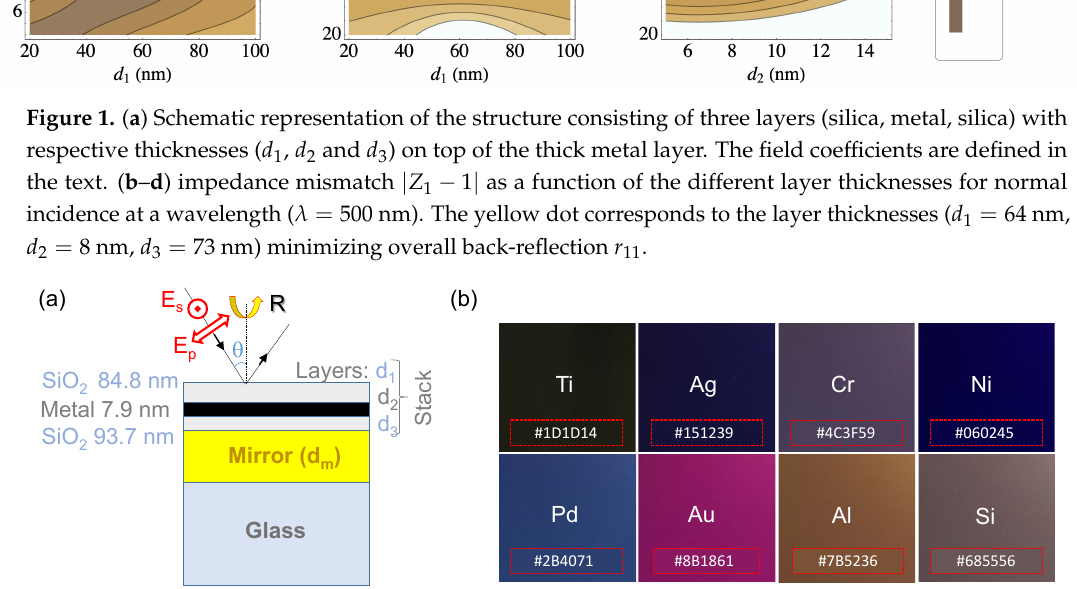
Figure 2. Black metals. ( a ) schematic of the structure of stacked nano-films [11] investigated for reflectance and absorbance control; the numerically optimized thicknesses for black-Ti are shown (see Section 4.1 for details); ( b ) photos of reflected colors under fluorescent white light illumination for various materials in layer two ( d 2 ). Hexadecimal color codes with the respective colors are shown on the images. The samples are all fabricated with the same target thicknesses for all layers: layer-1 d 1 = 84.8 nm, layer-2 d 2 = 7.9 nm, layer-3 d 3 = 93.7 nm. The thickness of the back Ti mirror was d m = 100